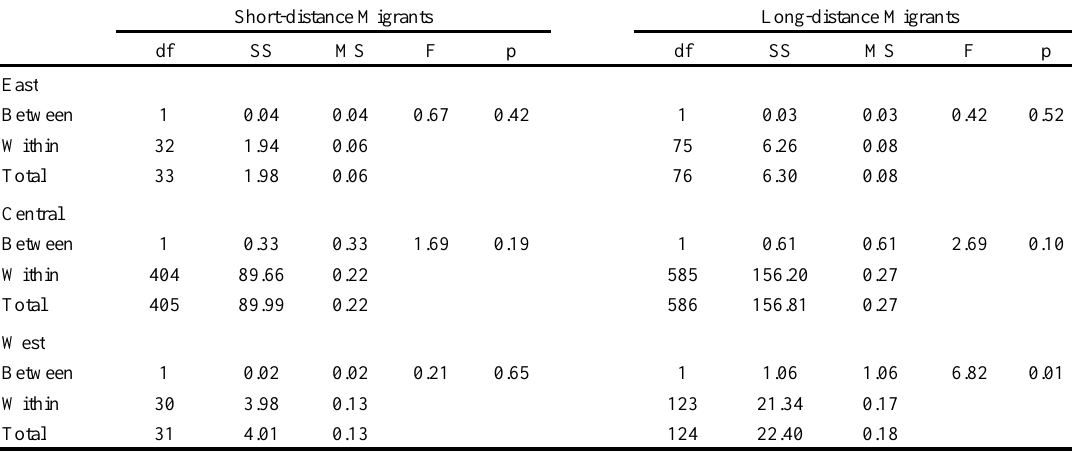
Table 3. Analysis of variance for circular data results comparing migration directions between spring and fall for short vs. long- distance migrants, respectively, based upon subsets of banding and recovery locations for 1261 passerines banded and recovered between 1914 and 2004.